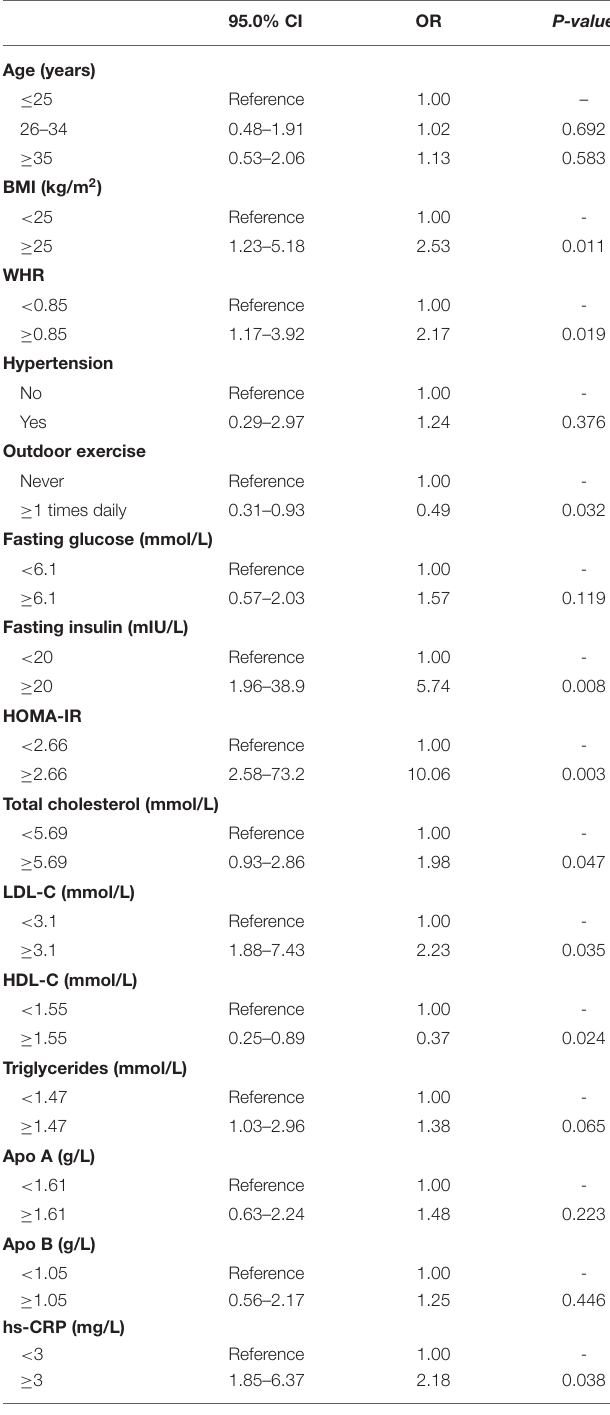
TABLE 4 | Multinomial logistic regression model of risk factors for vitamin D deficiency in women with R P-value